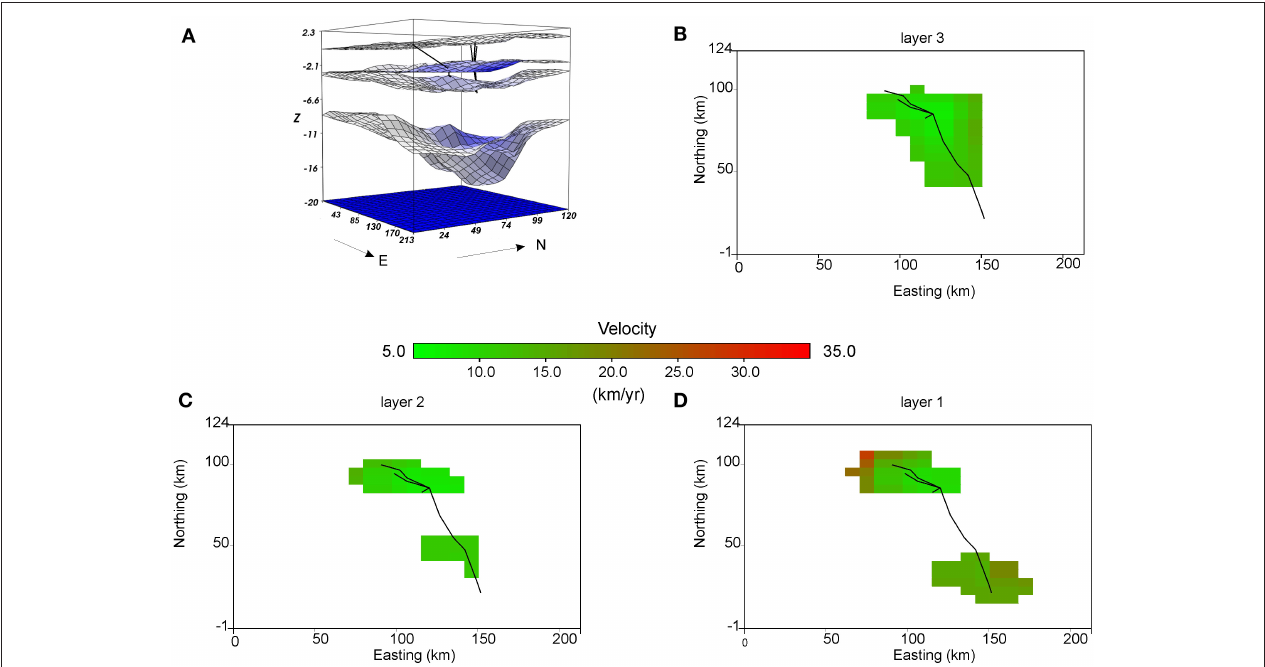
FIGURE 10 | Tomographic inversion. (A) 3D Velocity model, with the rays traced (black lines); (B) plan view of the velocity distribution in the lowermost layer: the pixels with low ray-coverage are masked in white; (C) the same in the intermediate layer; (D) the same in the shallowest layer. Black lines in (A–D) indicate the ray traces. Origin of model:11.8 ◦ E, 45.6 ◦